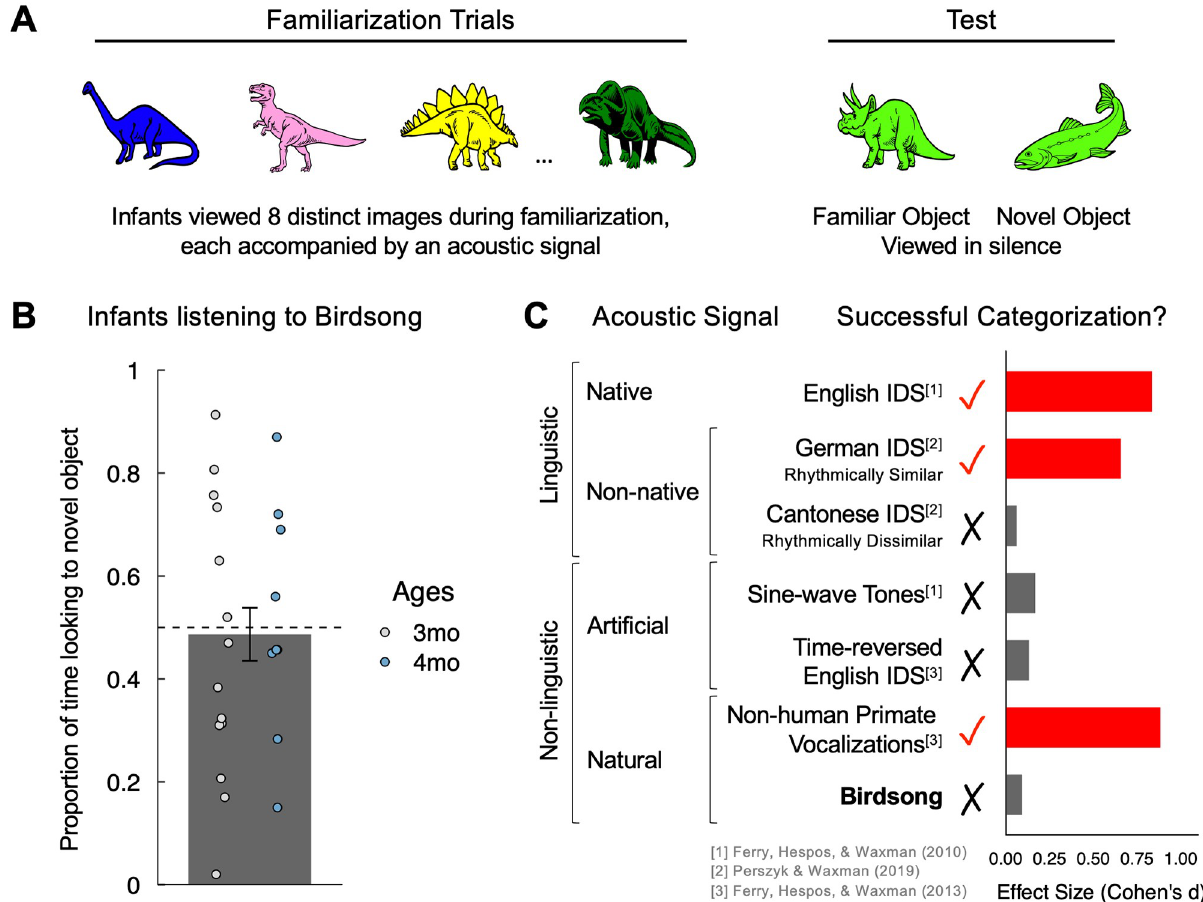
Fig 1. Experimental design and results from current study. (A) The experimental design of the object categorization task in the current study was identical to that of previous studies. During familiarization, each infant viewed eight distinct visual images, presented sequentially. Each image was accompanied by a pre-recorded acoustic signal. The acoustic signal accompanying the images during familiarization was the only factor that differed among studies. At test, each infant viewed two images: a new member of the now-familiar category (“Familiar Object”) and a member of a novel category (“Novel Object”). Test images were presented simultaneously, in silence. (B) Infants in the current experiment, who listened to the zebra finch song during familiarization, showed no looking preference towards either of the test objects, indicating that listening to zebra finch song does not support object categorization in 3- and 4-month-olds ( N = 23; p > 0.05; error bars represent ± 1 SEM). (C) Object categorization outcomes for the current study (zebra finch song) and previously tested acoustic signals. Effect size for the influence of each acoustic signal on Object Categorization (mean proportion looking to the novel object compared to 50% chance) was computed separately for each age group (3- and 4-month-olds) and then averaged.